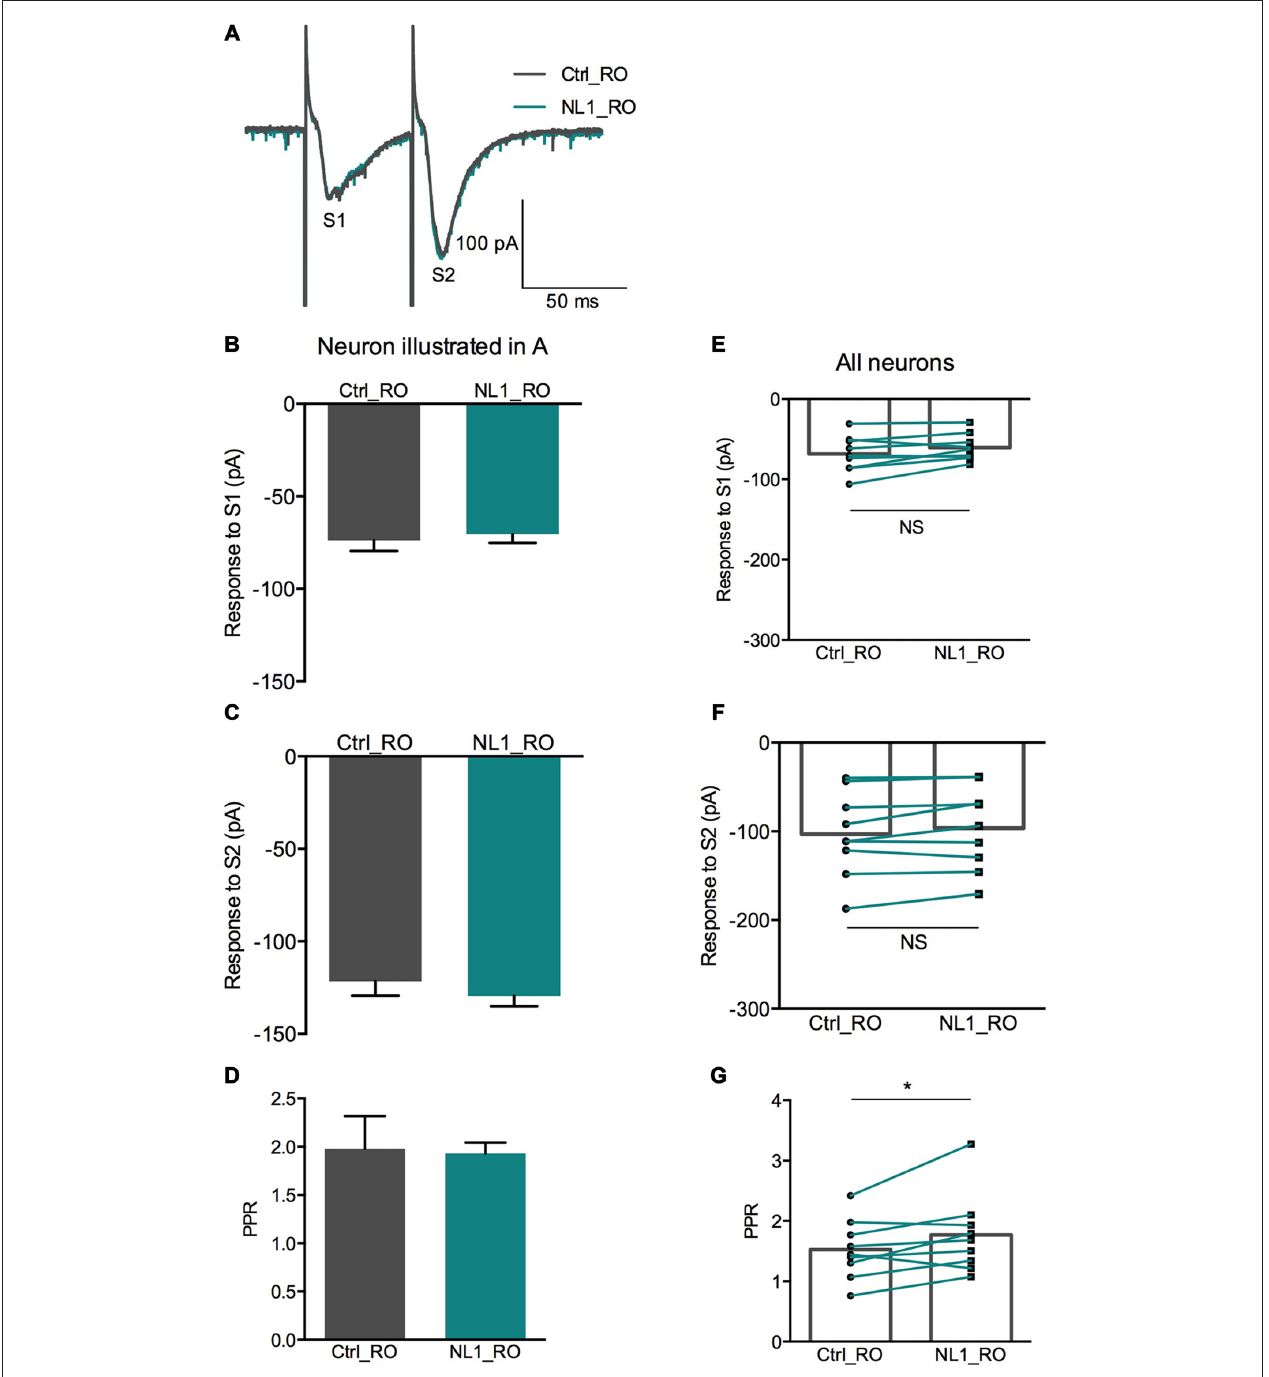
FIGURE 5 | RO 64-5229 reduces the presynaptic inhibitory effect of NL1. (A) EPSCs evoked by mossy fiber stimulation in a CA3 neuron in the presence of RO 64-5229 (50 µ M) under control conditions (gray) and after one puff of NL1 (teal) near the apical dendrite. (B–D) Response of a CA3 neuron to two stimulations (S1 and S2) under control conditions (iron) and after puffing ecto-NL1 near the apical dendrite of the recorded neuron (teal). (B) The amplitude of the first EPSC was slightly decreased (from − 73.8 ± 5.8 to − 70.38 ± 4.9 pA, p = 0.65, unpaired t -test; n = 30 sweeps). (C) The amplitude of the second EPSC was slightly increased (from − 121.5 ± 7.8 to − 129.4 ± 5.7 pA; p = 0.40, unpaired t -test; n = 30 sweeps). (D) The PPR was slightly decreased (from 1.98 ± 0.3 to 1.93 ± 0.1; p = 0.13, Kolmogorov Smirnov test; n = 30). (E–F) Results for all cells tested ( n = 9), no significant decreases for the first ( p = 0.069) and second ( p = 0.087) EPSCs (Wilcoxon matched-pairs signed-rank test). (G) Significant increase for the PPR for all cells together (from 1.5 ± 0.16 to 1.7 ± 0.22; ∗ p = 0.04, Wilcoxon matched-pairs signed-rank test; n = 9). In (E–G) bars show the mean values and lines correspond to individual pairs of values.